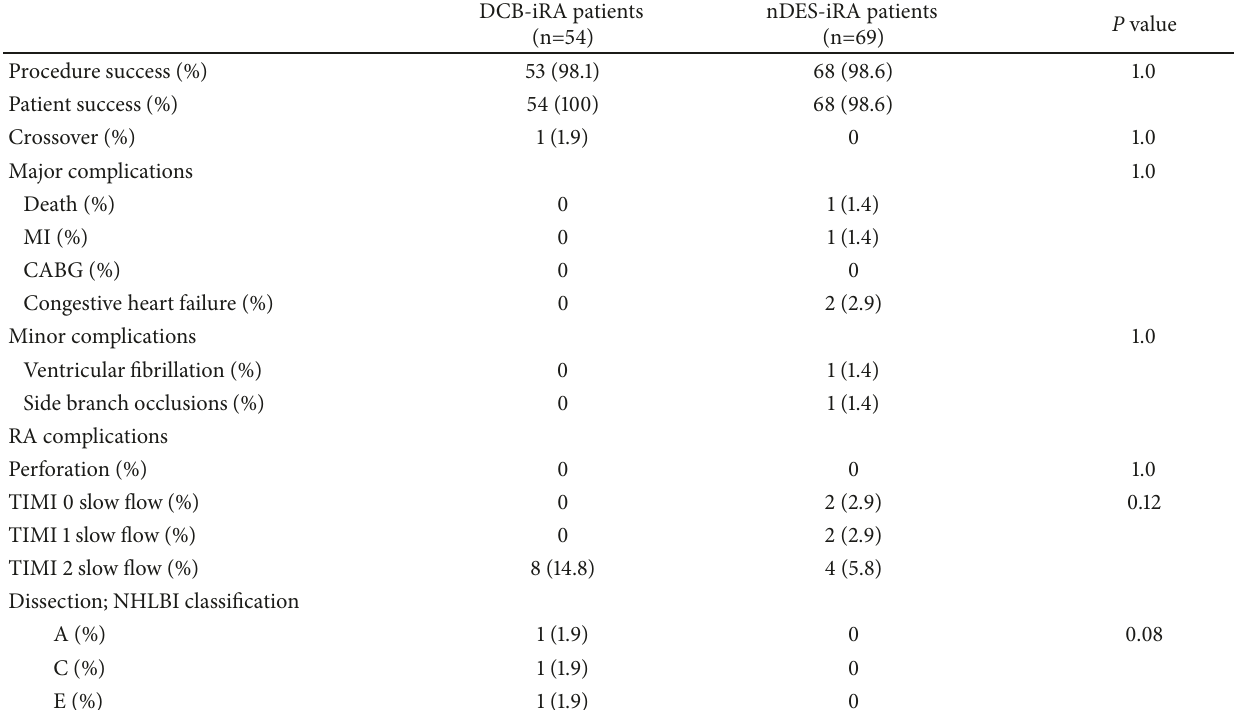
Table 3: Acute procedural outcomes.